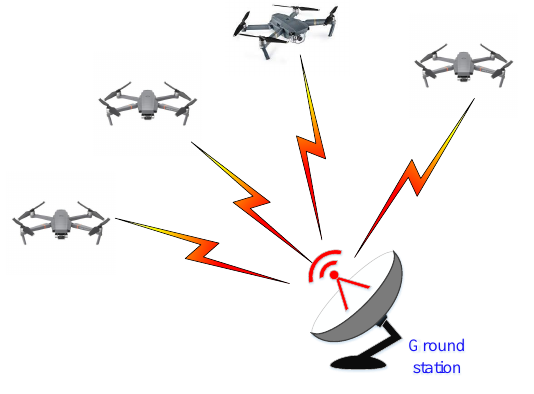
Figure 5. The centralized control scheme for multiple UAVs.